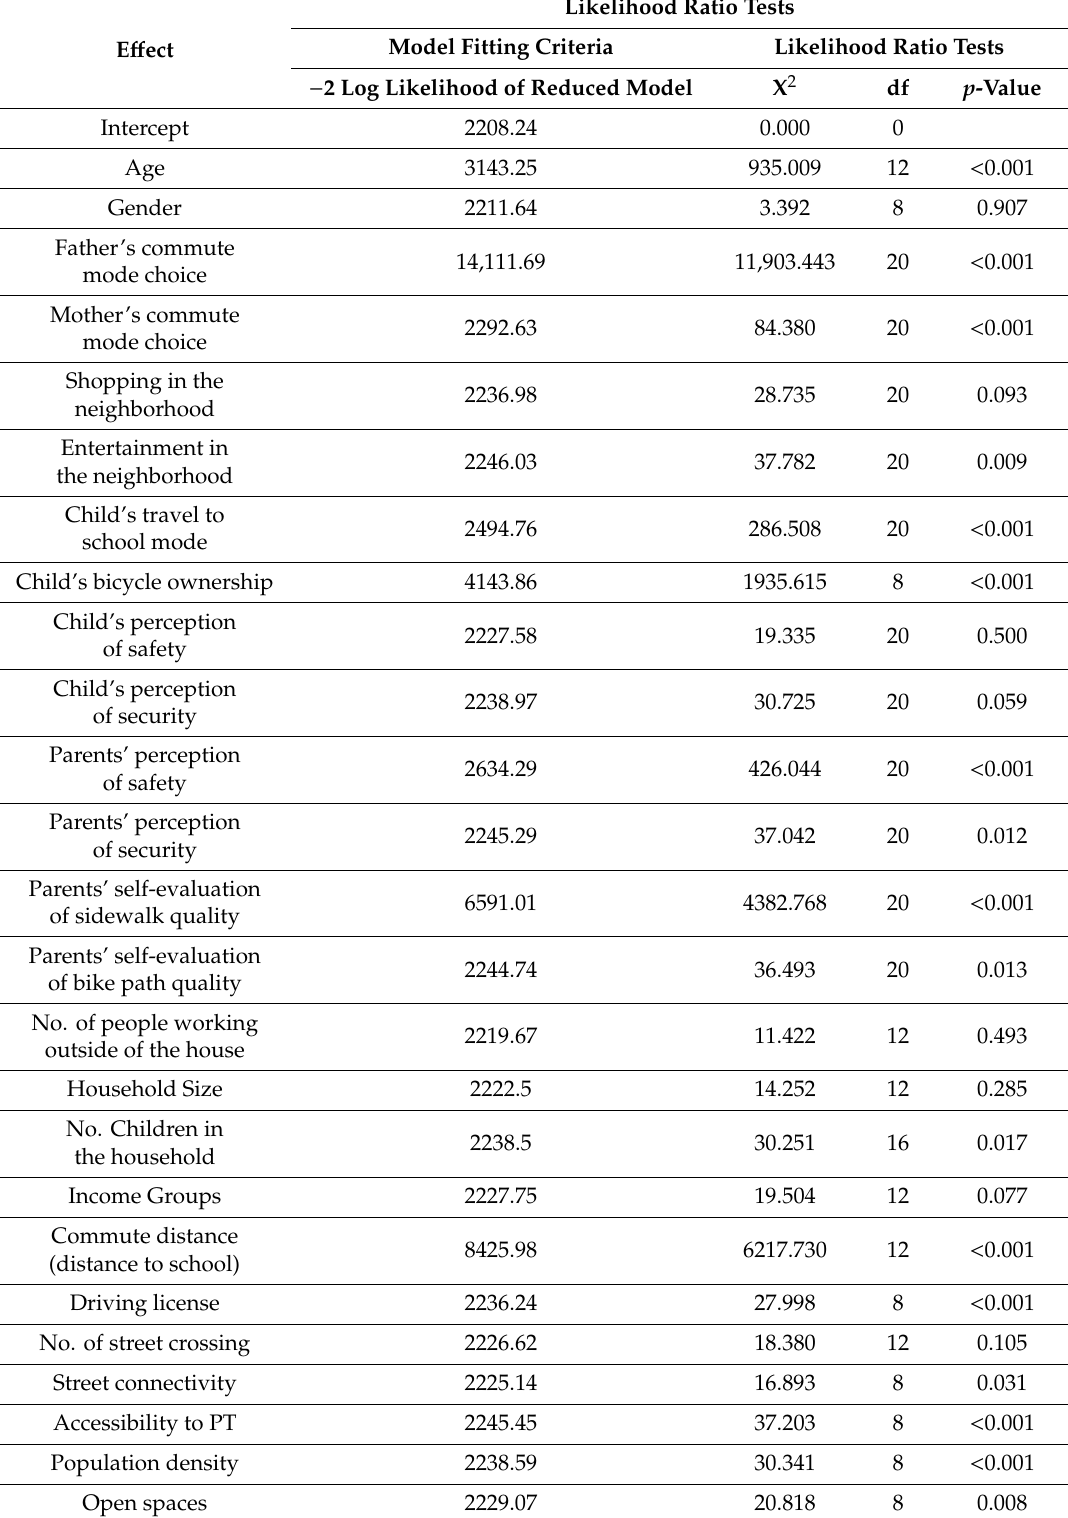
Table 4. The significance of variables of the MNL model with the dependent variable of “individuals accompanying a child to school” ( n =